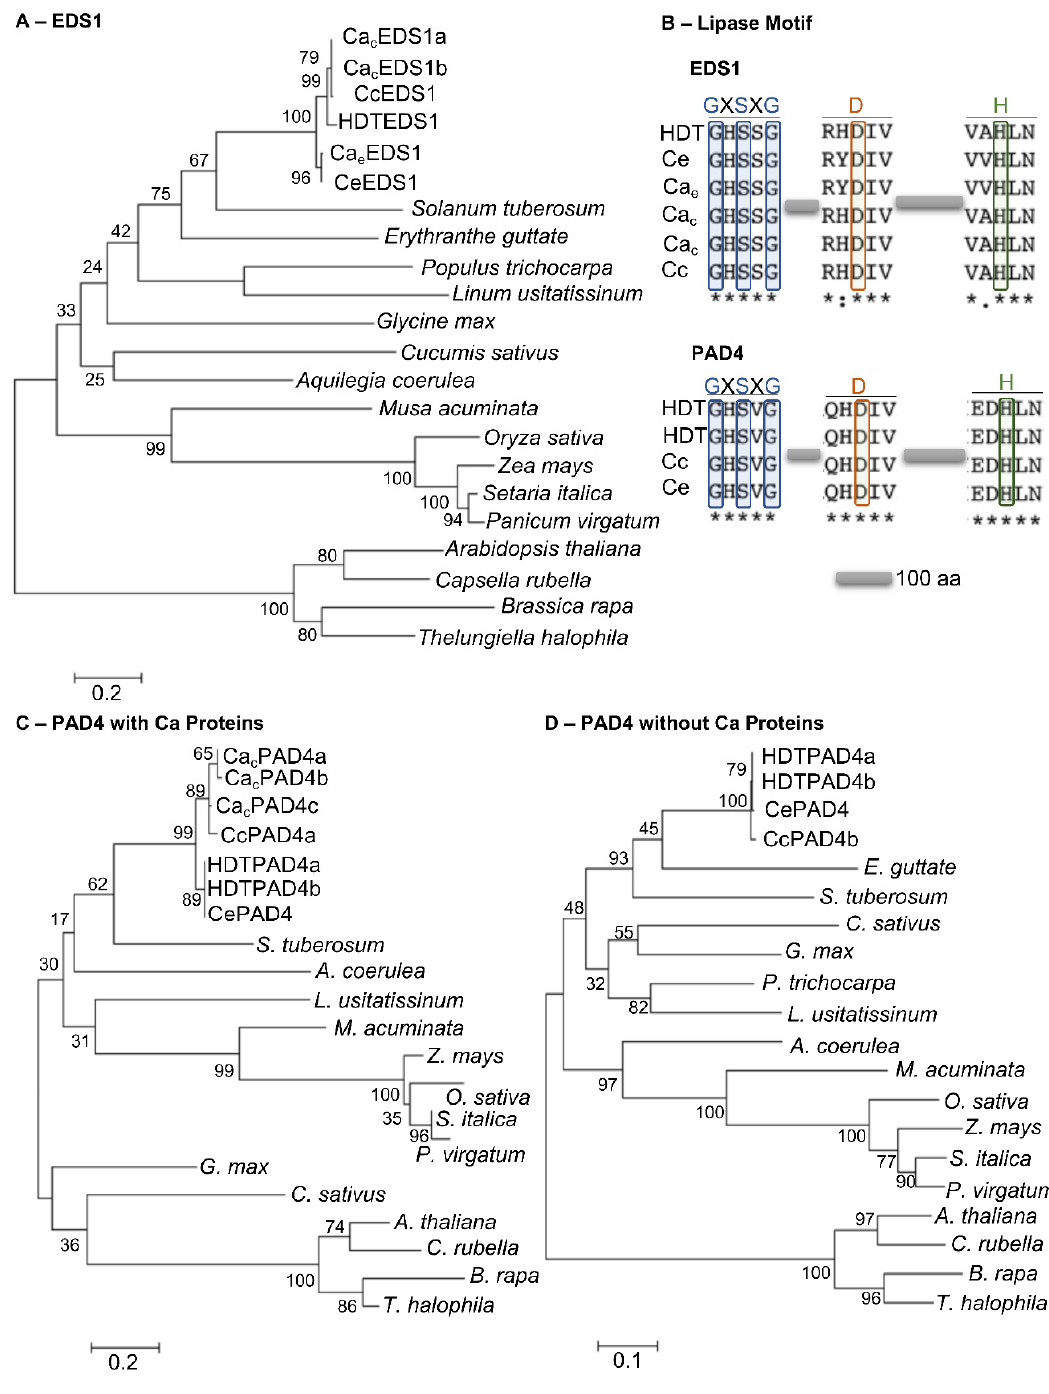
Figure 7. ( A ). Phylogenetic tree of putative EDS1 proteins from Coffea arabica (Ca), C. canephora (Cc), C. eugenioides (Ce), Coffea Timor hybrid (HDT) and a selected group of orthologs sequences. ( B ). Conservation of lipase catalytic triad residues in EDS1 and PAD4 Coffea spp. sequences aligned with T-Coffee. Conserved positions within the catalytic S-D-H of α / β hydrolases, namely the GxSxG motif, are shown. ( C ). Phylogenetic tree of putative PAD4 proteins from C. arabica (Ca), C. canephora (Cc), C. eugenioides (Ce), Coffea Timor hybrid (HDT) and a selected group of orthologs sequences. ( D ). Phylogenetic tree of putative PAD4 proteins from C. canephora (Cc), C. eugenioides (Ce), C. Timor hybrid (HDT) and a selected group of orthologs sequences. All trees were drawn to scale and constructed using the maximum likelihood method conducted in software MEGA7. Protein sequence IDs are included in Supplementary File S1. * Conserved amino